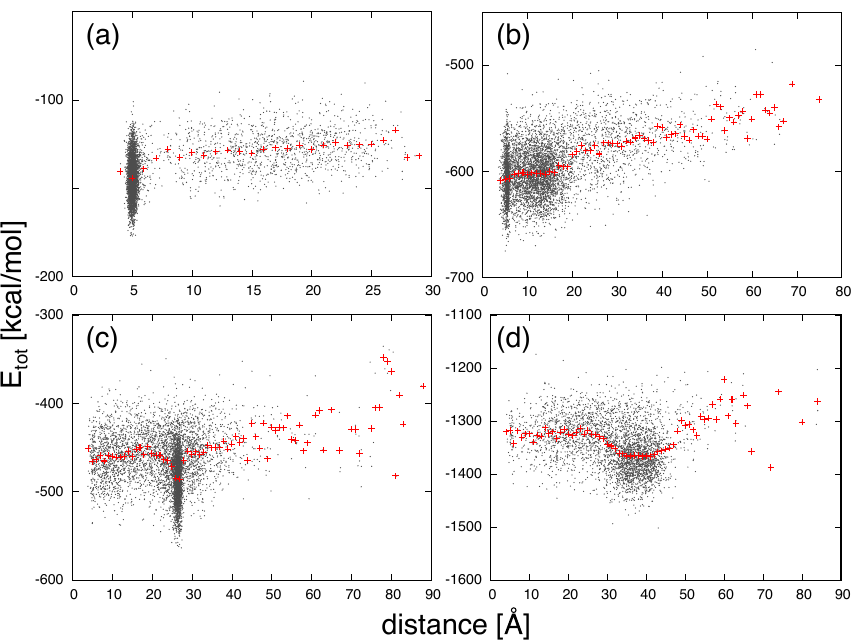
Figure 5. Total energy ( E tot ) of ( a ) CLN025, ( b ) mGTT, ( c ) mNuG2, and ( d ) m α 3D as a function of the end-to-end distance. A red point represents the average value for each width 1